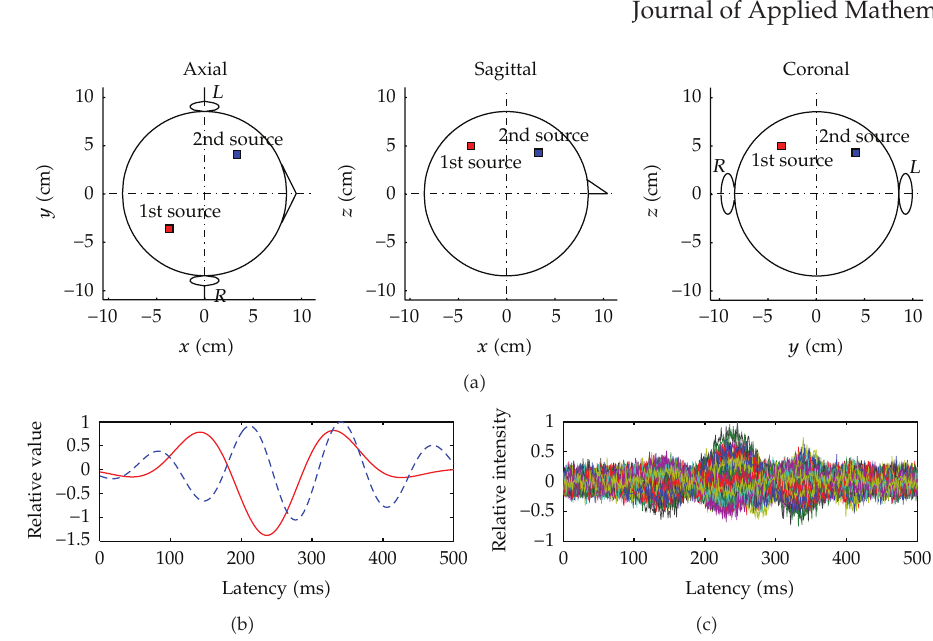
Figure 1: Two source locations and head geometry description (cid:2) a (cid:3) , time courses of dipole sources, first with a solid and second with a dashed line (cid:2) b (cid:3) , and over-plotted synthetic MEG measurement data (cid:2) SNR of 1 (cid:3) for 160 sensors (cid:2) c (cid:3)